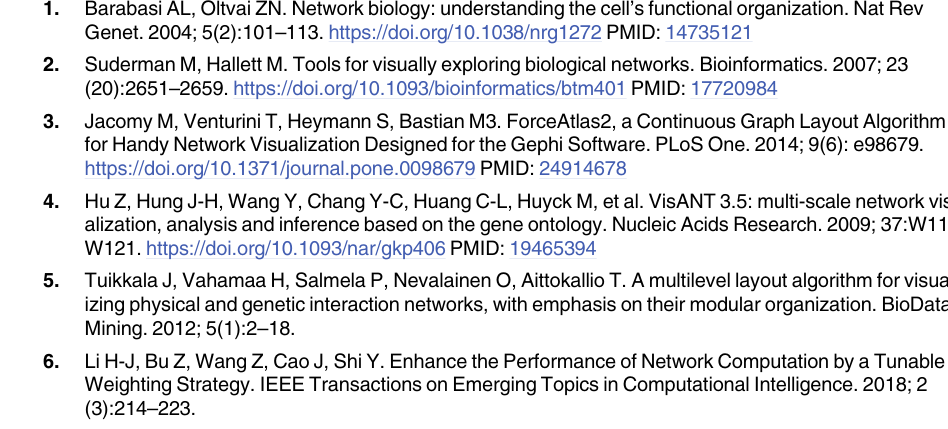
S1 Table. Data of test results for ten networks for the Hybrid Grid Layout, GBL and GML algorithms.